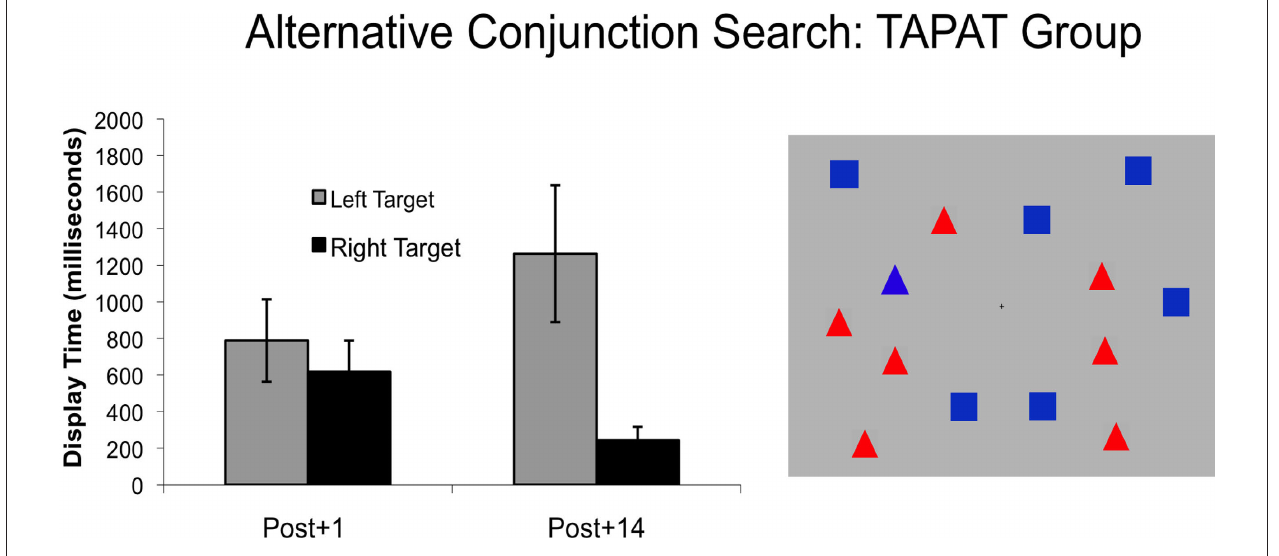
Figure 5 | Alternative conjunction search results for TAPAT group. The display time is the amount of time that the target (blue triangle) had to be shown for patients to correctly identify it 75% of the time. This was calculated separately for right and left targets (error bars represent the standard error of the